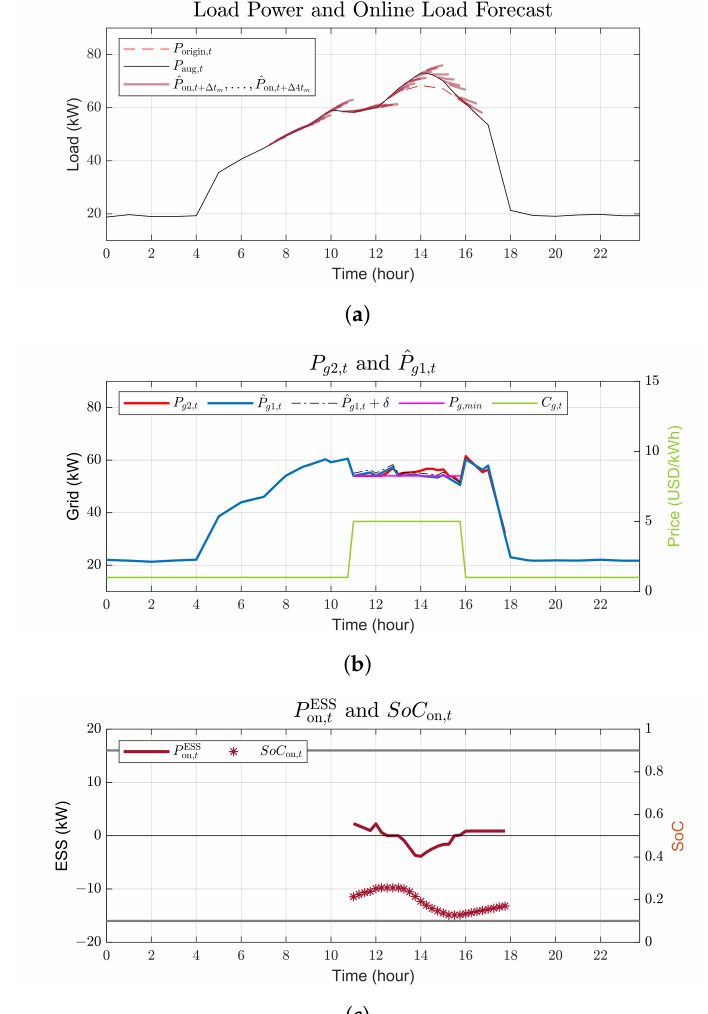
Figure 16. Online ESS operations with initial SoC on, t value being 0.2. ( a ) Online load forecast, ( b ) The estimated power ˆ P g 1, t and real power P g 2, t from the main grid by using both ESS off and ESS on , ( c ) The amount of charging or discharging of ESS on and SoC on, t